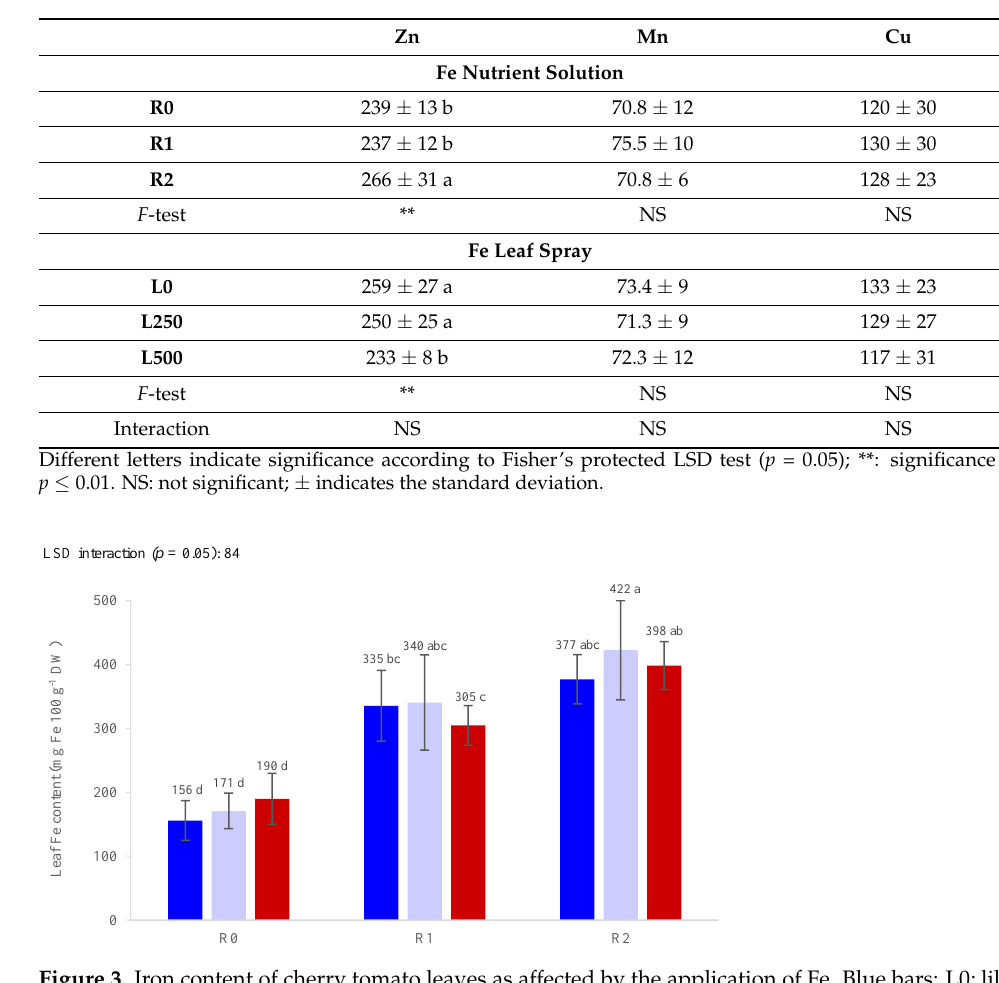
Table 5. Effects of Fe application on the micronutrient composition ( µ g 100 g − 1 FW) of fruits from the 2nd cluster of cherry tomato plants.